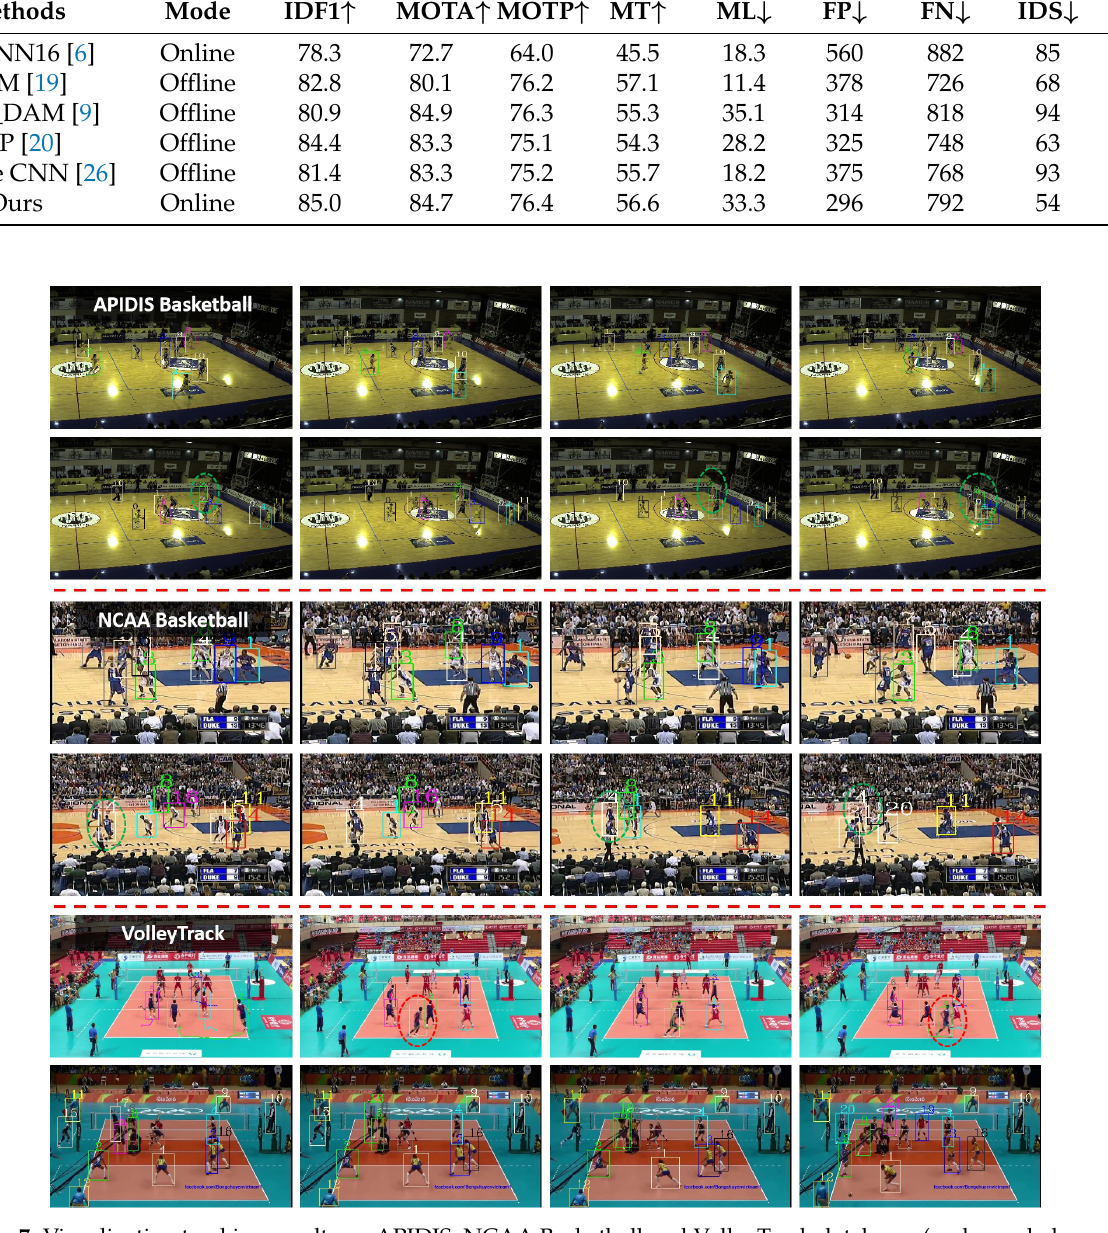
Figure 7. Visualization tracking results on APIDIS, NCAA Basketball and VolleyTrack databases (each row belongs to a sequence). The athletes in green dashed circles are success cases and the ones in red dashed circles are failure